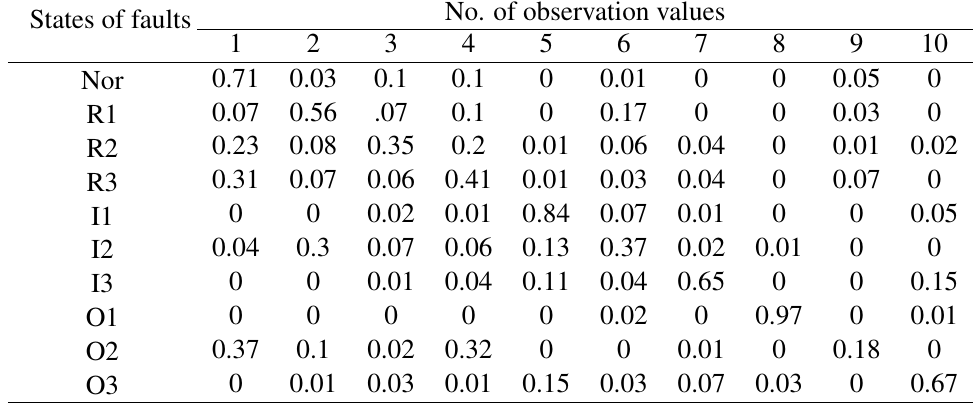
Table 3 Some obtained observation values as the input of HMM.